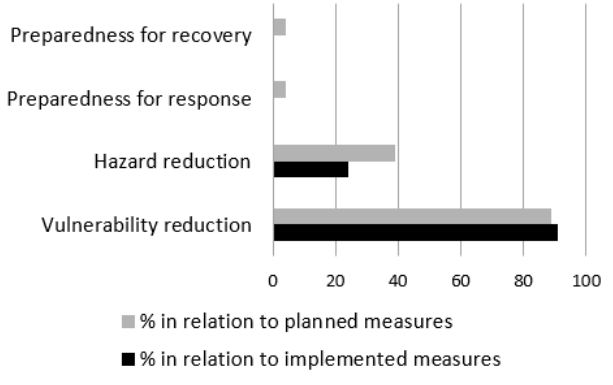
Fig. 4 . Ecological structures used in identified measures. Multiple categorizations of single measures are included.